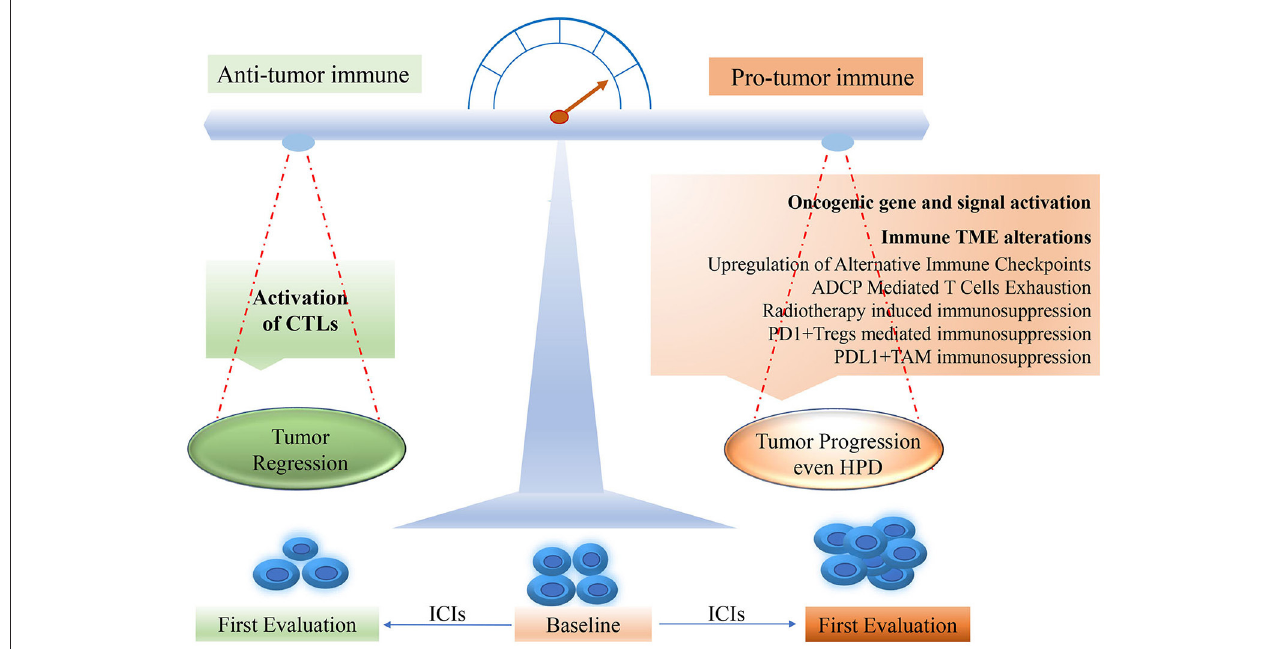
FIGURE 1 | The potential mechanism for HPD occurring in ICI treatment. HPD, hyperprogressive disease; PD-1, programmed death-1; PD-L1, programmed death ligand-1; CTL, cytotoxic T lymphocyte; TME, tumor microenvironment; ICI, immune checkpoint